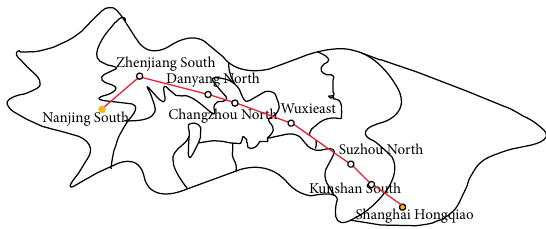
Figure 2: The running state of train 𝐽